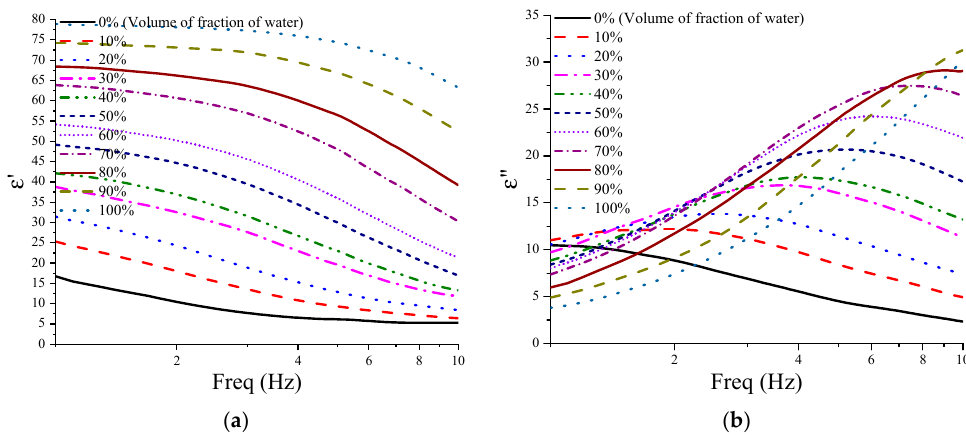
Figure A1. Frequency dependence of complex permittivity [44]: ( a ) real part; ( b ) imaginary part. Table A1. Measured real dielectric spectra for water–ethanol mixture at 25 ◦ C and different volume fractions; data reported from